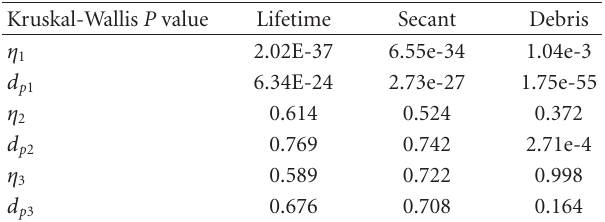
Table 2: The P values for sensitivity of each